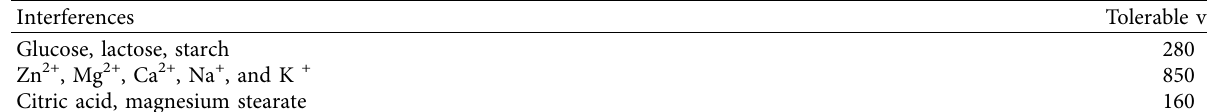
Table 6: Tolerable limits of 10 μ g · mL − 1 LD using the proposed procedure.